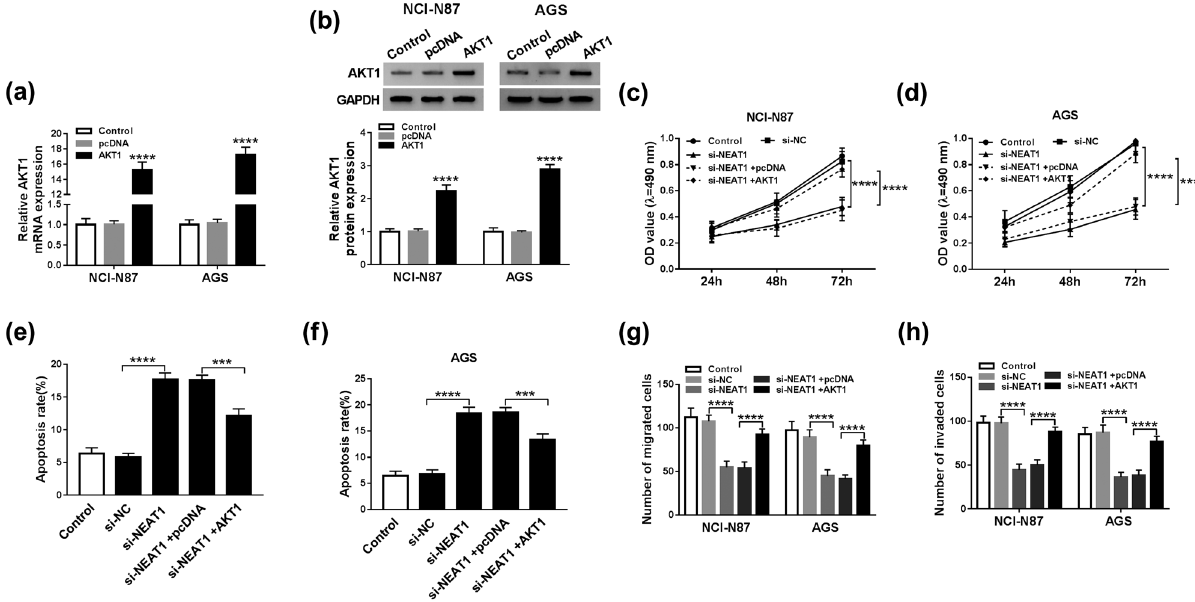
Figure 5: Overexpression of AKT1 restored the si - NEAT1 - induced e ff ects on cell proliferation, apoptosis, and metastasis of GC cells. ( a and b ) QRT - PCR and Western blot were used to measure the overexpressed e ff ect of AKT1. ( c and d ) Cell proliferation in NCI - N87 and AGS cells transfected with si - NEAT1 and AKT1 was detected by MTT. ( e and f ) Cell apoptosis was determined by fl ow cytometry. ( g and h ) Migrated and invaded cells were examined by transwell assay. *** P < 0.001, **** P <